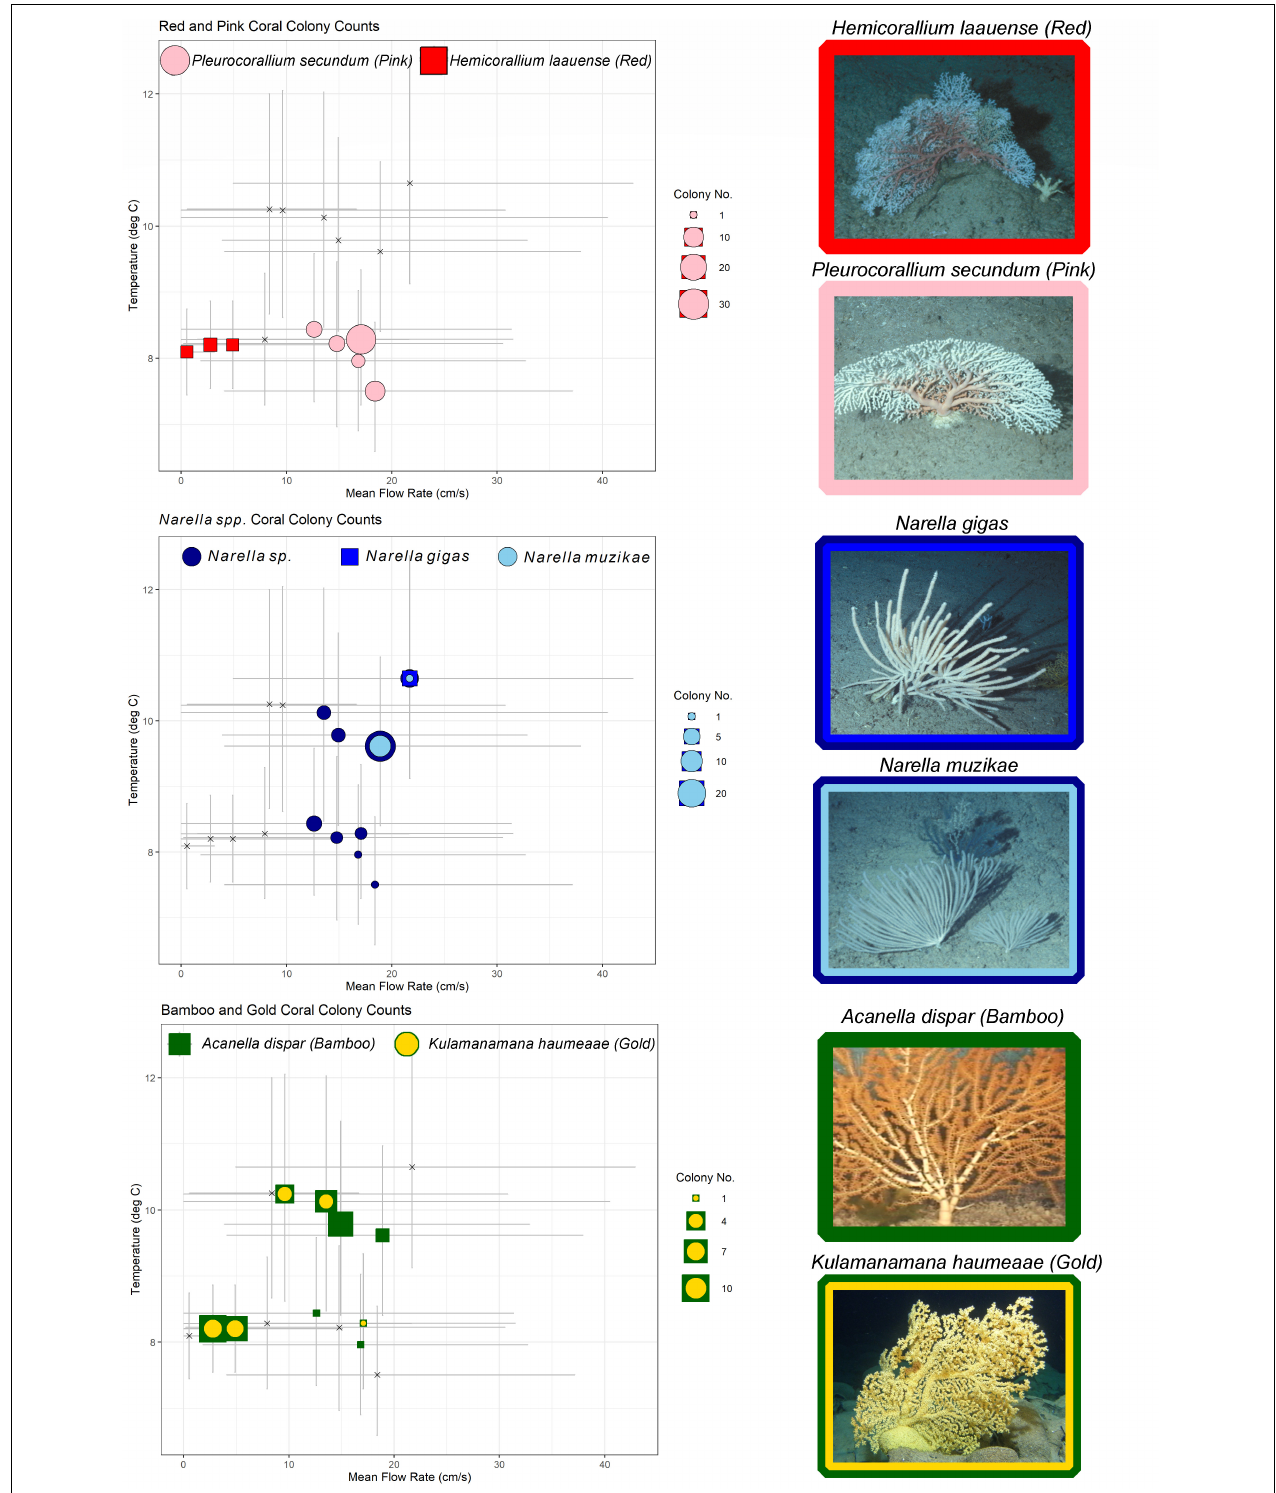
FIGURE 7 | Mean and standard deviation of temperature and flow for the flow and tiltmeter instruments by focal coral taxon. Top row shows red and pink colonies at the same temperature but different flow rates. Middle row shows Narella spp. colonies at all temperatures but clustered at the high extreme of flow. Bottom row shows bamboo colonies at all temperatures and flows and the parasitic gold coral colonizing the bamboo host colonies most at lower flow sites. Photos courtesy of Hawaii Undersea Research Laboratory.